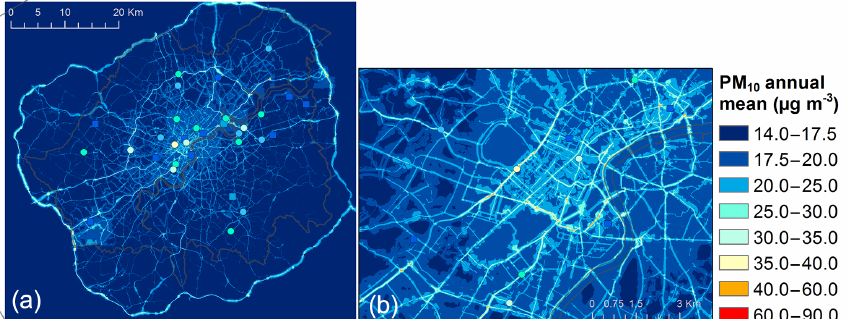
Figure A1. PM 10 annual average concentration contours from the coupled model for the whole of Greater London (a) and an area of central London (b) , with monitoring data overlaid – round symbols for near-road sites and square symbols for background sites.